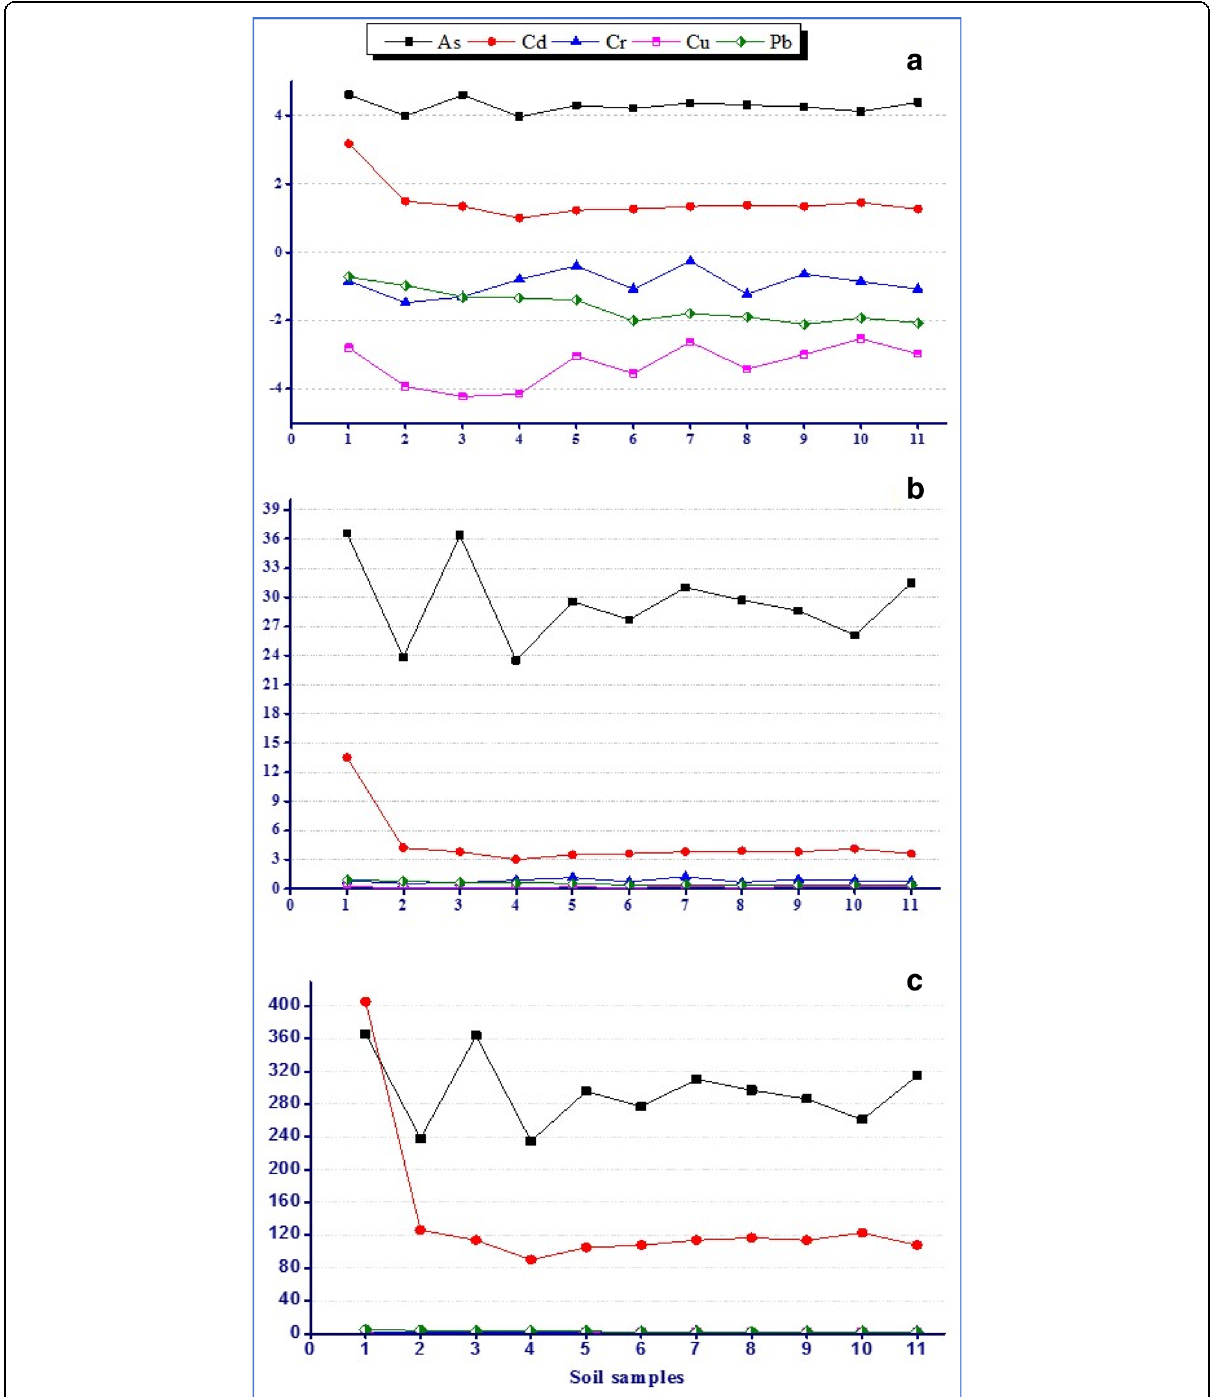
Fig. 7 Variation of As, Cd, Cr, Cu, and Pb I geo ( a ), CF ( b ), and Er ( c ) in Orabi